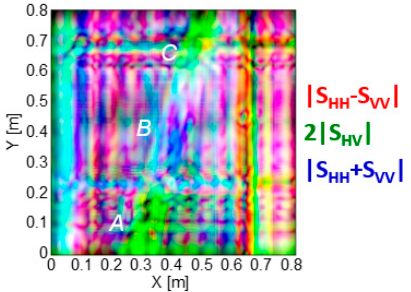
Figure 10. RGB image generated from the 2D survey on the Type II wall specimen in Figure 1b at a depth of 2.3 cm from the wall surface.